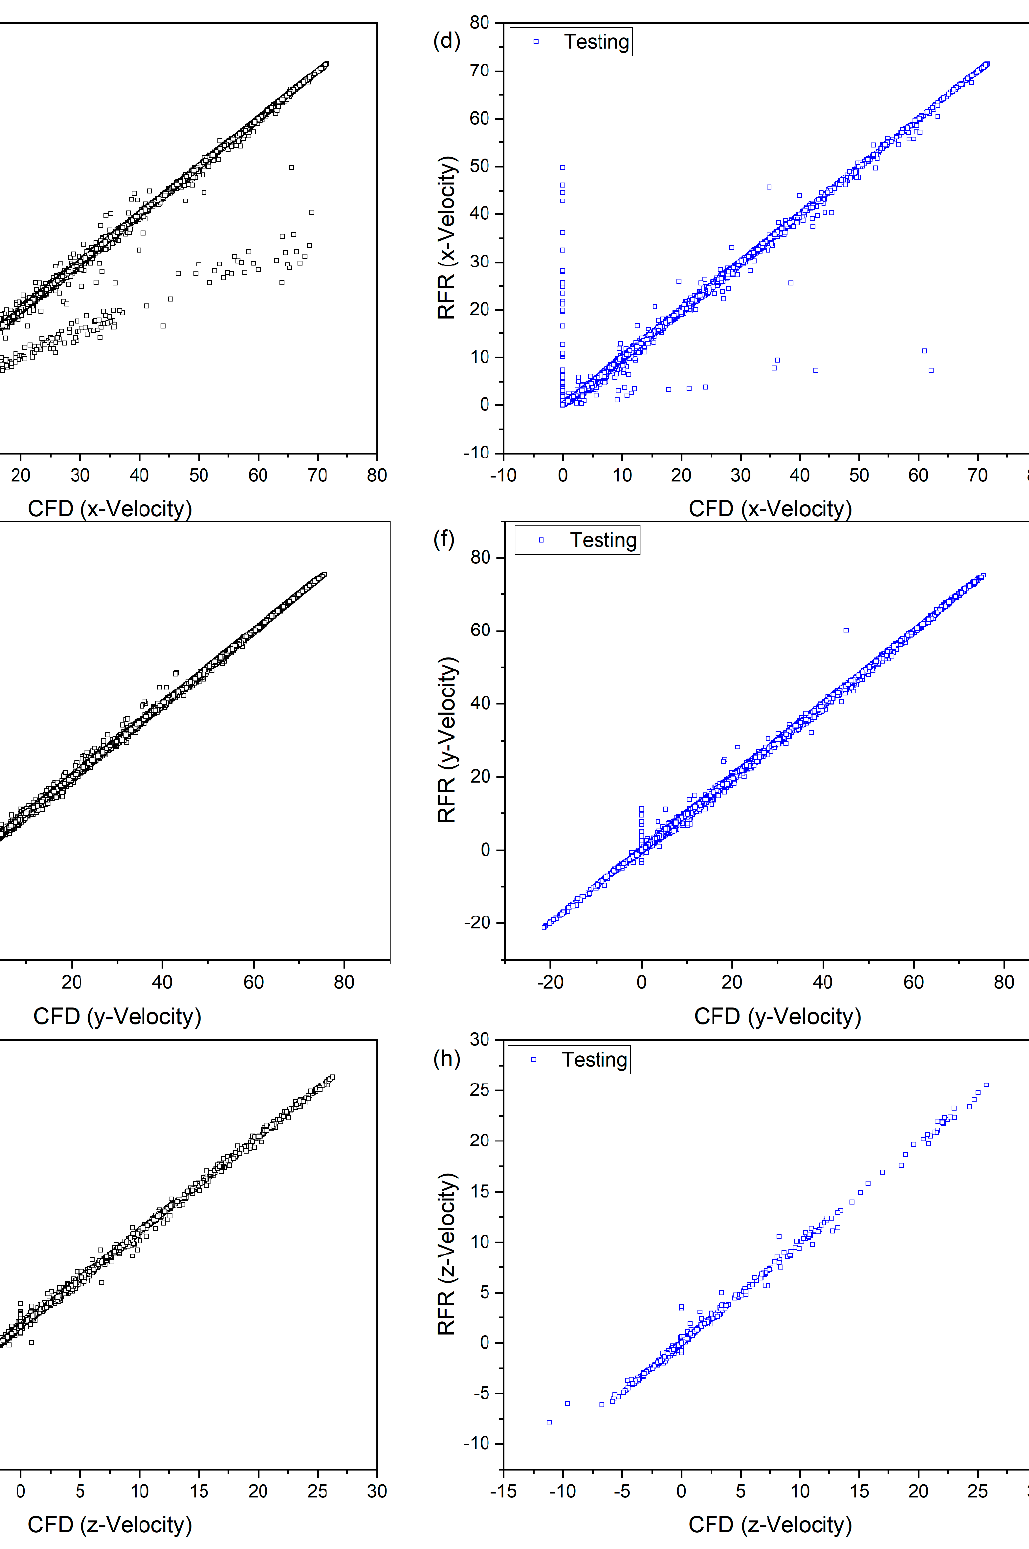
Figure 5. CFD versus RFR predicted velocity parameters for training (subfigure ( a , c , e , g )) and testing (subfigure ( b , d , f , h )) data. ( a , b ) axial velocity ( c , d ) x-velocity ( e , f ) y-velocity ( g , h ) z-velocity.